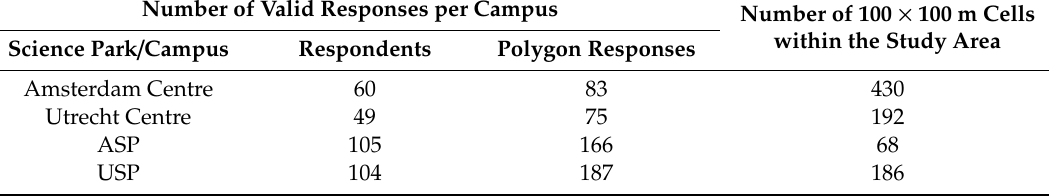
Table 2. Number of VGI (volunteered geographic information) responses in each Science Park